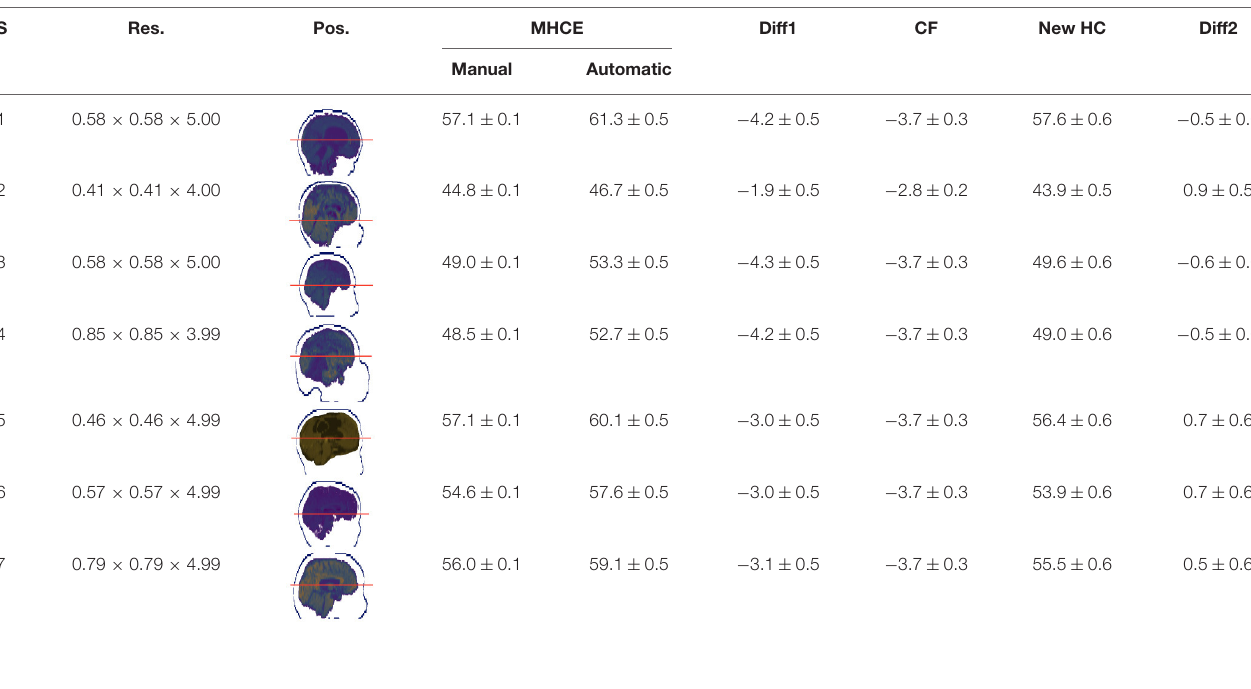
TABLE 4 | Comparison between manually and automatically obtained MHCs using correction factors. S